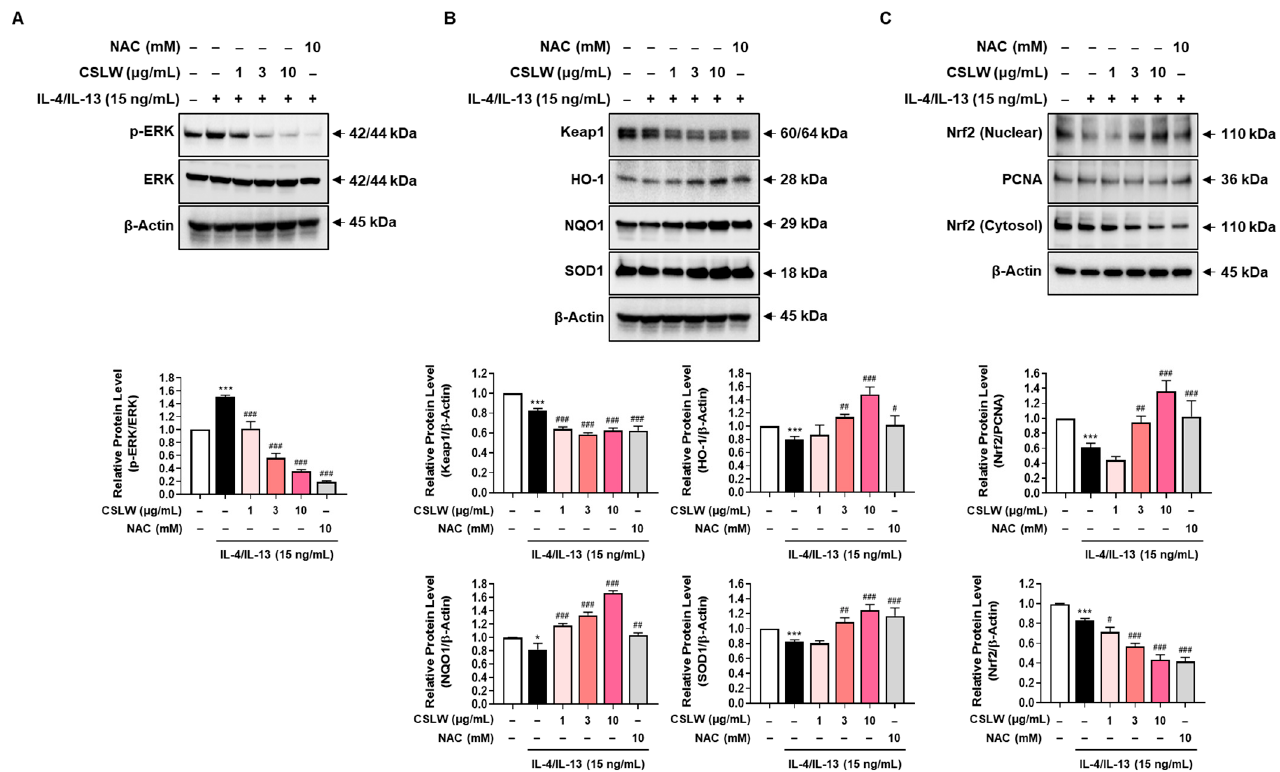
Figure 7. Effect of CSLW on the activation of the EPK − MAPK and Nrf2 signaling pathways in HNEpCs. ( A – C ) Cells were treated with CSLW (1, 3, and 10 µ g/mL) or with NAC (10 mM) along with IL − 4/IL − 13 (15 ng/mL) for 1 h. ( A – C ) Expressions of phospho − ERK (p − ERK), ERK, Keap1, HO − 1, NQO1, SOD1, Nrf2, and PCNA were evaluated using Western blot analysis. Total β − Actin or PCNA was used to confirm equal sample loading. Images from Western blotting were quantified using ImageJ software. The data are presented as the means values ± SD; * p < 0.05 and *** p < 0.001 compared with the control cells; # p < 0.05, ## p < 0.01, and ### p < 0.001 compared with the IL-4/IL- 13-treated cells. CSLW, Caesalpinia sappan Linn. heartwood water extract; HNEpCs, human nasal epithelial cells; MAPK, mitogen-activated protein kinase; Nrf2, nuclear factor erythroid 2 − related factor